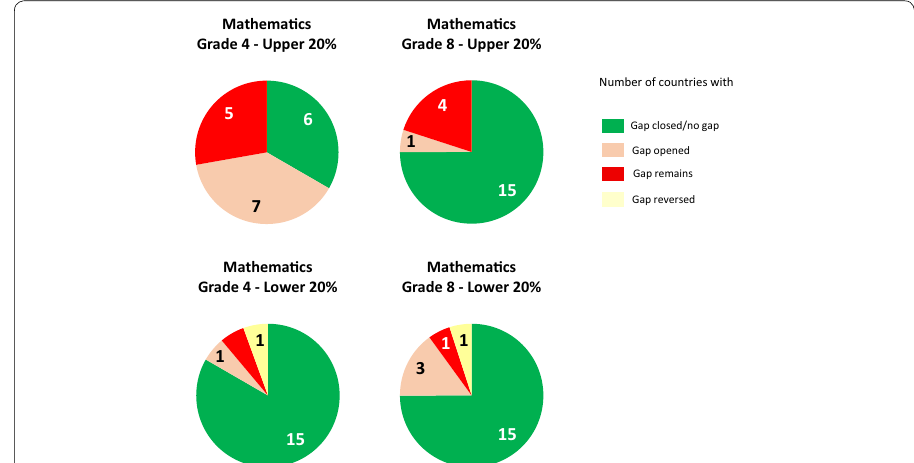
Fig. 4 Changes in gender gaps in mathematics achievement in grades four and eight in the group of the 20% highest achieving and the group of 20% lowest achieving students between 1995 and 2015. Example description of upper left pie chart (grade 4, upper 20% of distribution of math achievement): In five countries, a gender gap remained; in seven countries, a gender gap opened, i.e., developed where there was none before; in six countries, the gender gap closed or there is none in 2015 and there has not been a gap in 1995 neither